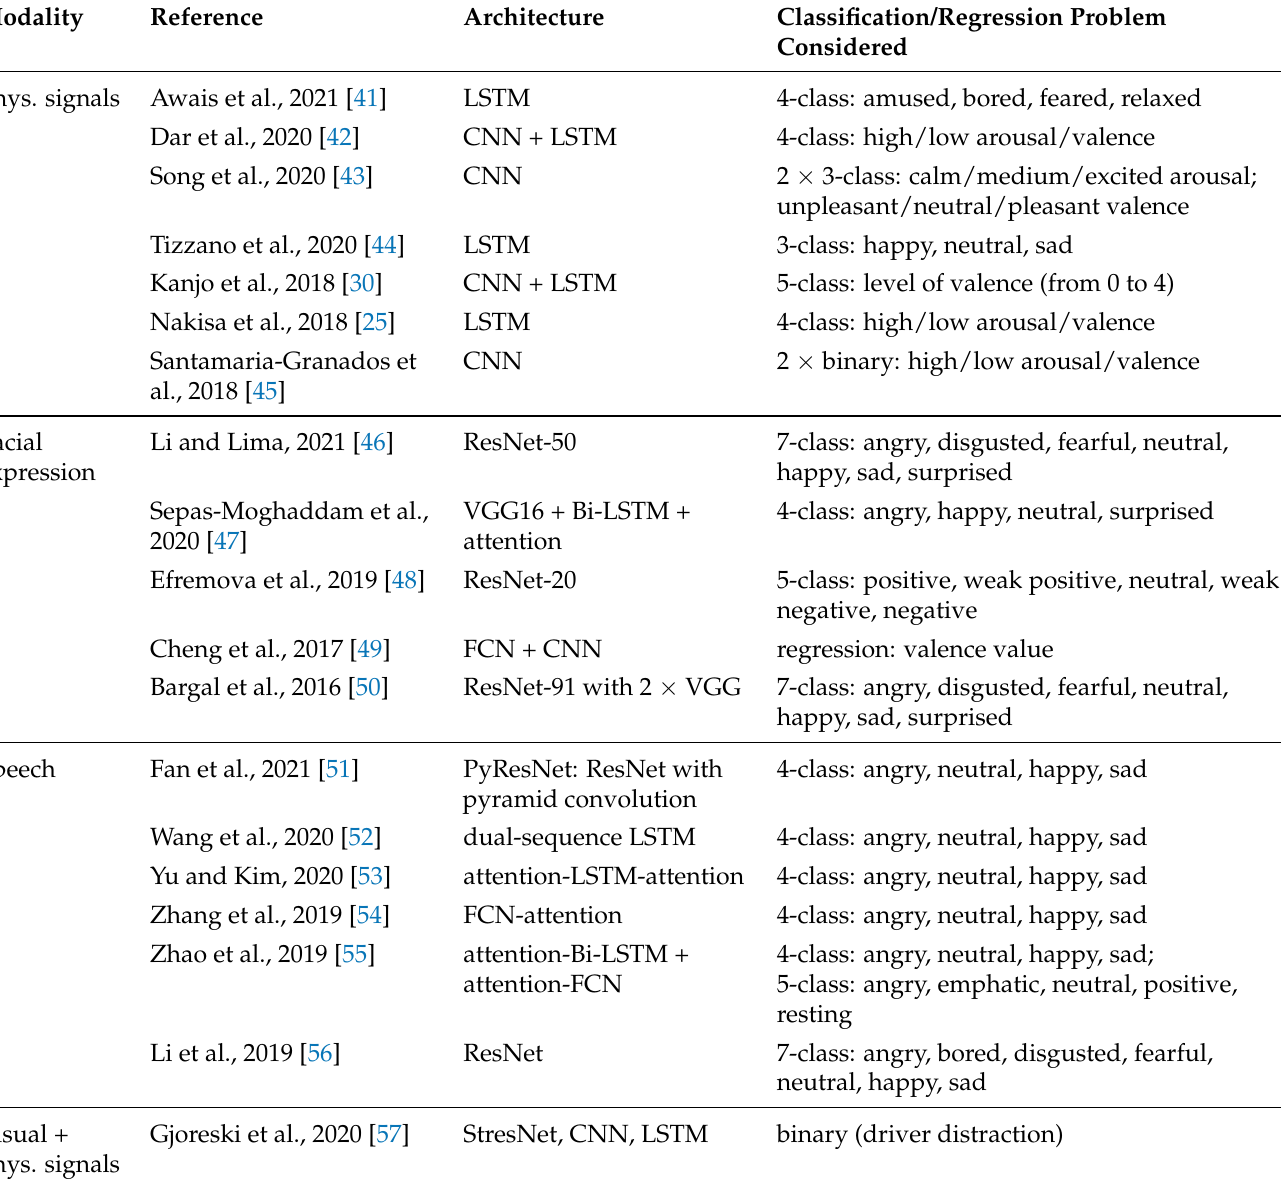
Table 2. The recent emotion recognition studies utilizing state-of-the-art deep learning